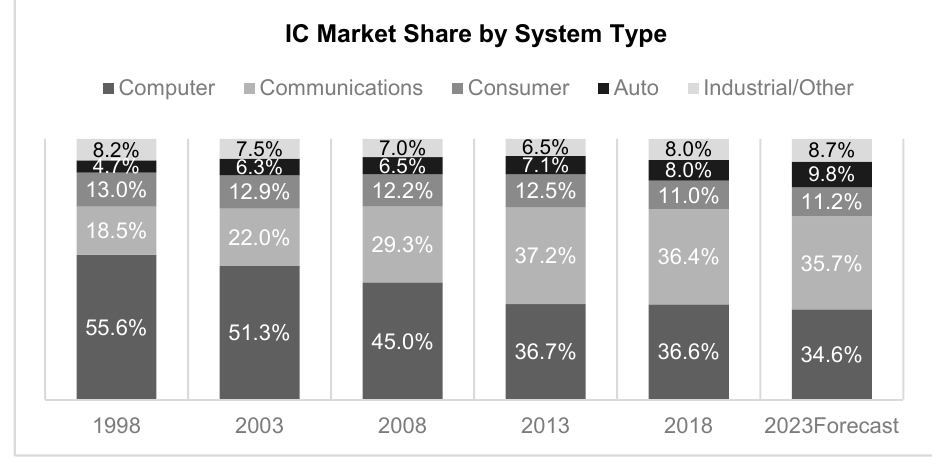
Figure 1. IC (Integrated Chipset) market share by system type ($). Source: IC insights.